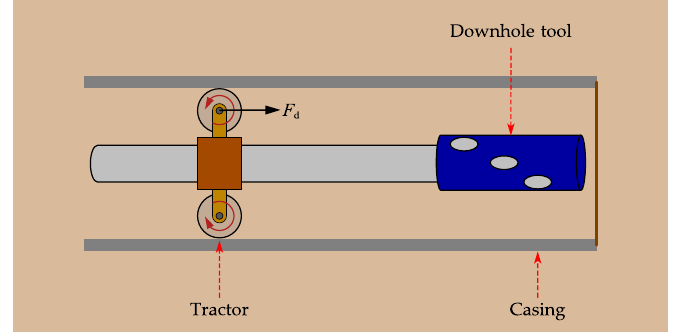
Figure 2. Schematic of a tractor.